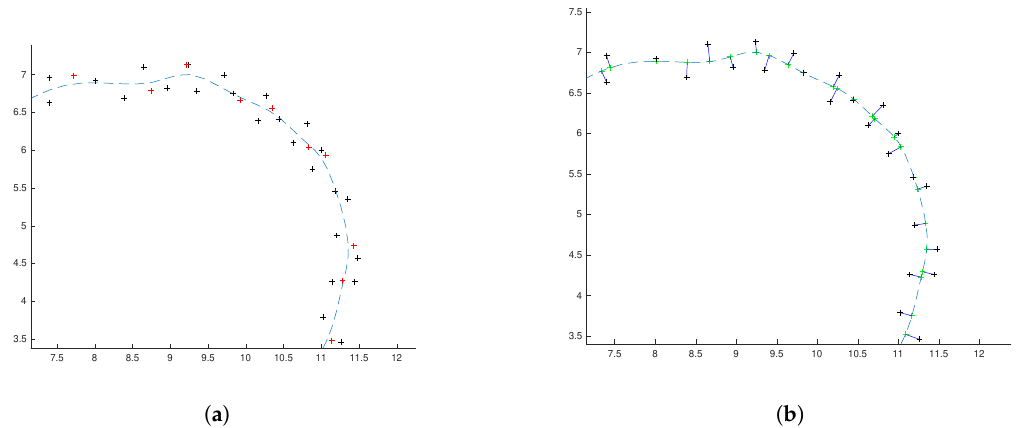
Figure 10. ( a ) The initial B-spline curve of the cloud points (black crosses) and new control points (red crosses), ( b ) the distance of the point cloud points and the computed curve line.